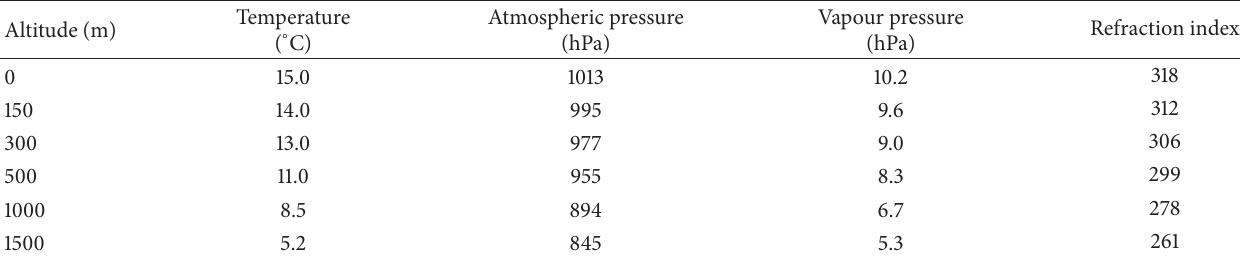
Table 2: Standard atmospheric parameters.